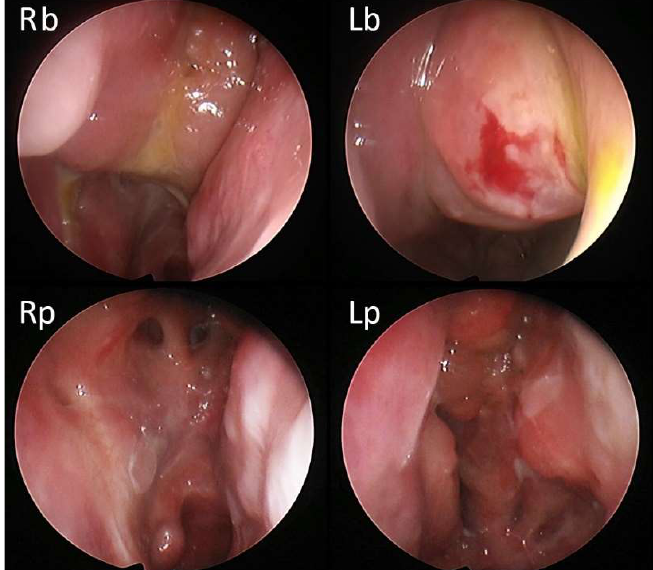
Figure 5. 61-year-old female patient with history of 6 previous surgeries, the last complicated with unilateral ophthalmoplegia and vision loss. At baseline, the NPS was 5/8 (Rb: right side at baseline; Lb: left side at baseline). After one month of therapy with dupilumab, the NPS decreased to 1/8 (Rp: right side post therapy; Lp: left side post